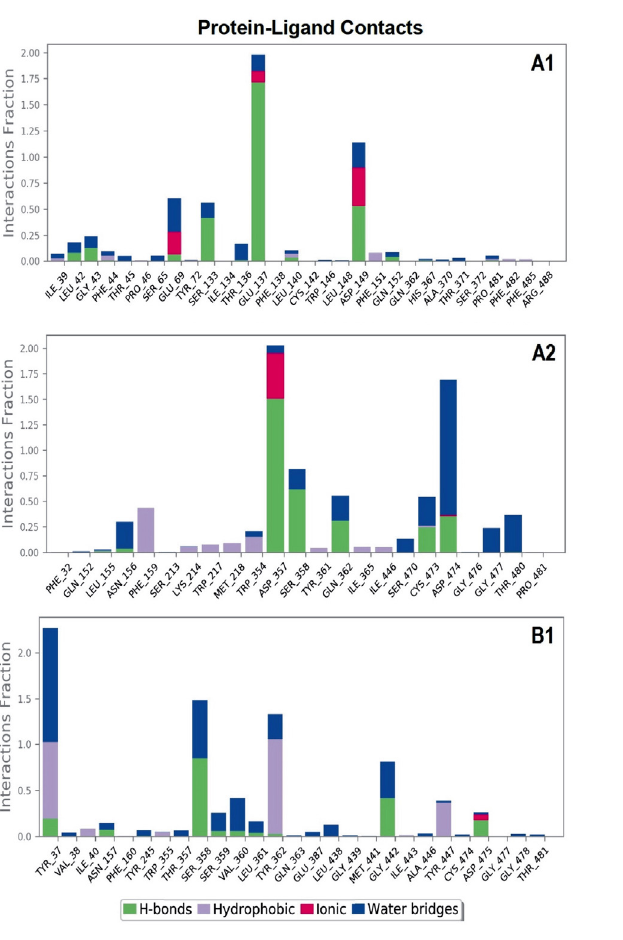
Figure 8: Protein-ligand contact interaction profile analyzed for the A1. OCT-1 and metformin, A2. OCT-1 and phenformin, B1. OCT-2 and met- formin, B2. OCT-2 and phenformin, C1. OCT-3 and metformin, and C2. OCT-3 and